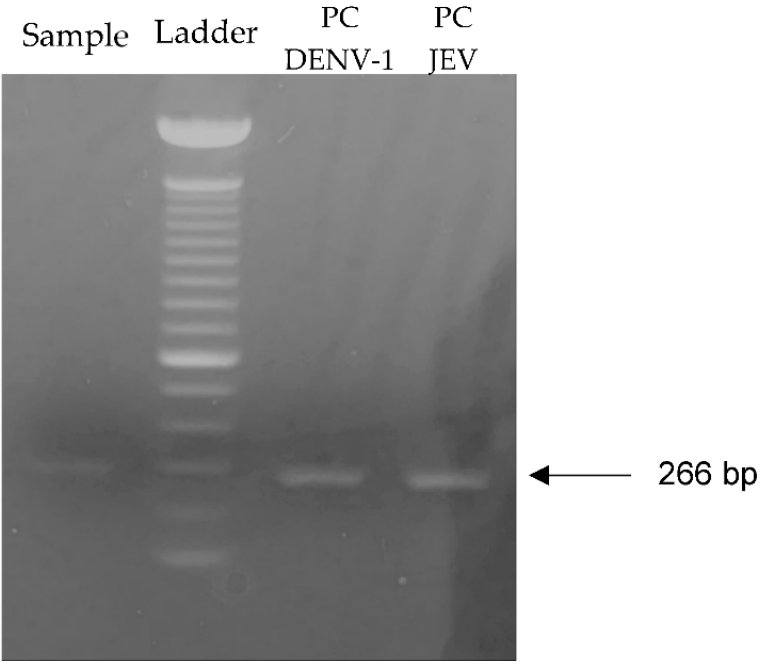
Figure 1. PCR result of the positive pool of Culex tritaeniorhynchus. The positive Culex tritaeniorhynchus sample was obtained from pool 6. PC DENV-1 and JEV represented the dengue virus serotype 1 and Japanese encephalitis virus that were used as positive controls. Both positive controls have the same band length of 266 bp.